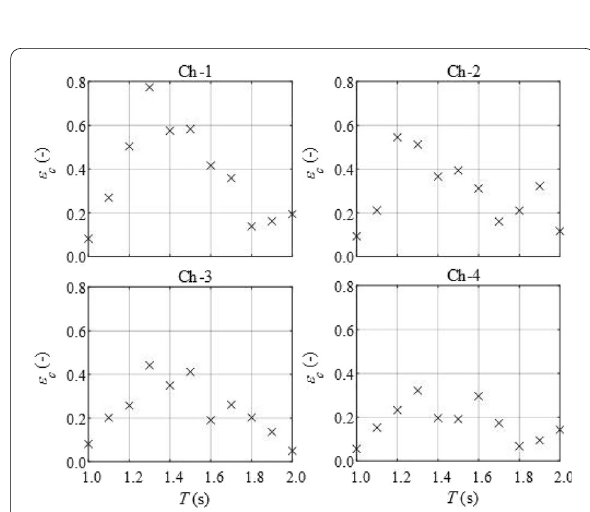
Figure 8 Capture width ratio ( ε c ) for each chamber of the MC-OWC device at a constant wave height H 250 mm and an orifice opening ratio R 2